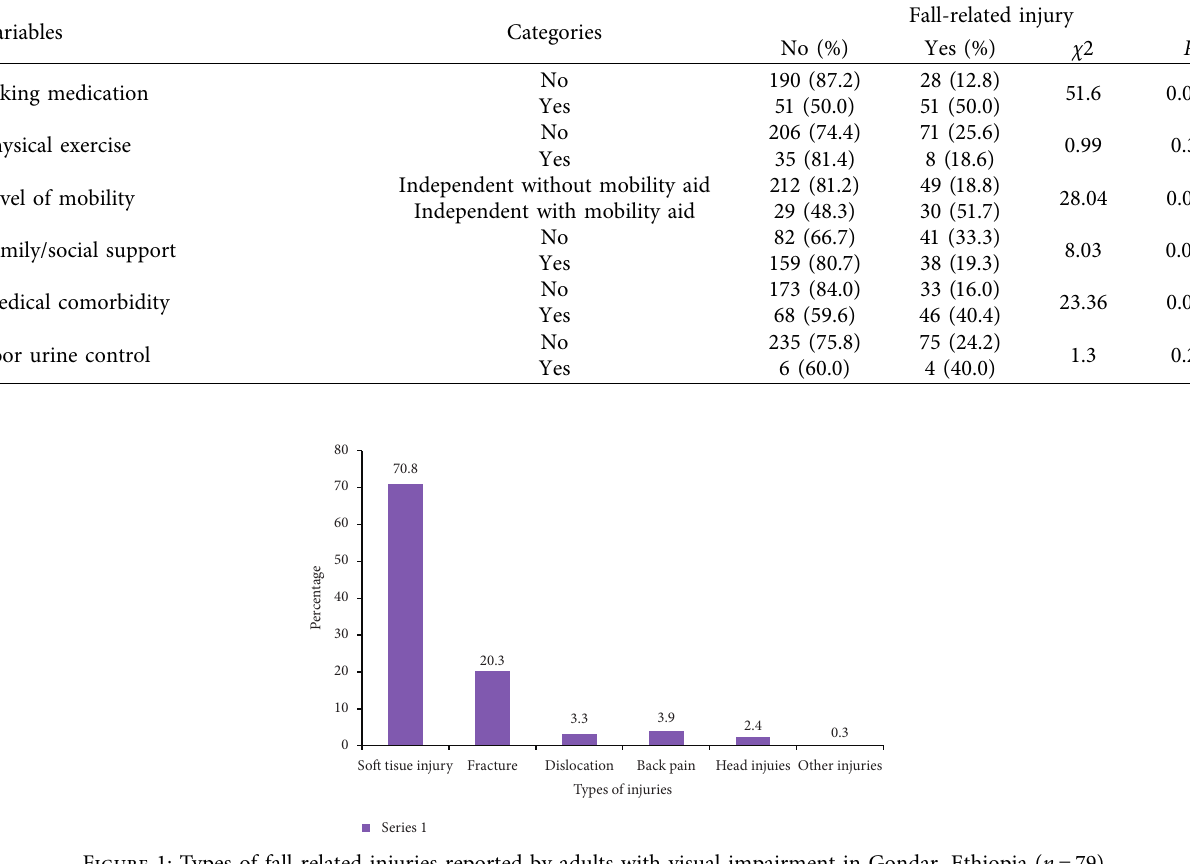
Figure 1: Types of fall-related injuries reported by adults with visual impairment in Gondar, Ethiopia ( n � 79). Table 4: Factors associated with fall-related injuries in adults with medically diagnosed visual impairment at Gondar, Ethiopia ( n � 320).